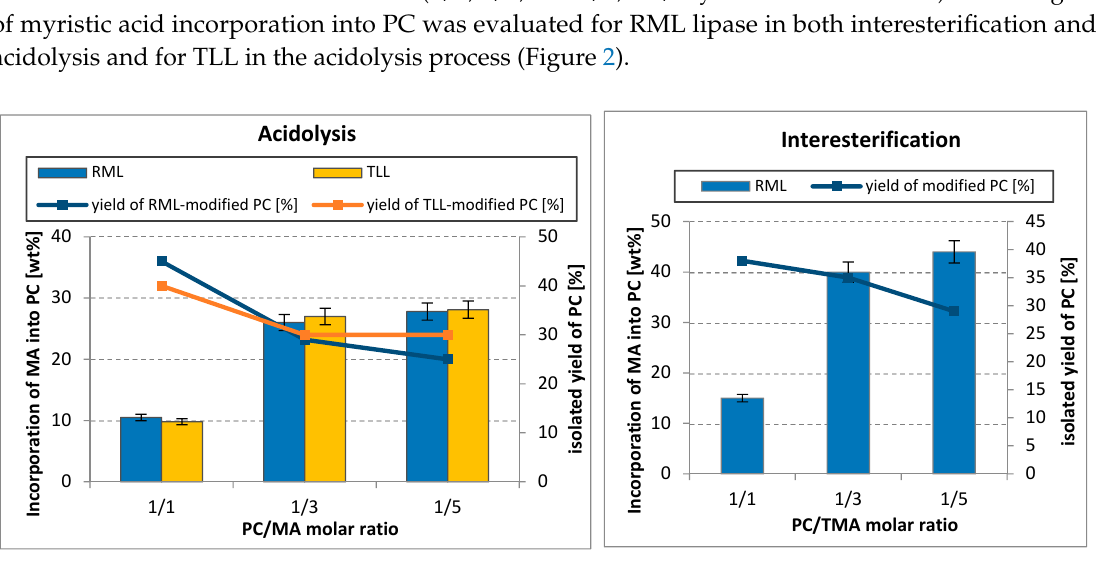
Figure 2. Effect of substrate molar ratio on the incorporation of myristic acid into egg-yolk PC and isolated yield of modified PC in acidolysis and interesterification (reaction condition: temperature, 50–52 °C; lipase dosage, 30%; solvent, hexane; 48 h). MA—myristic acid; TMA—trimyristin.